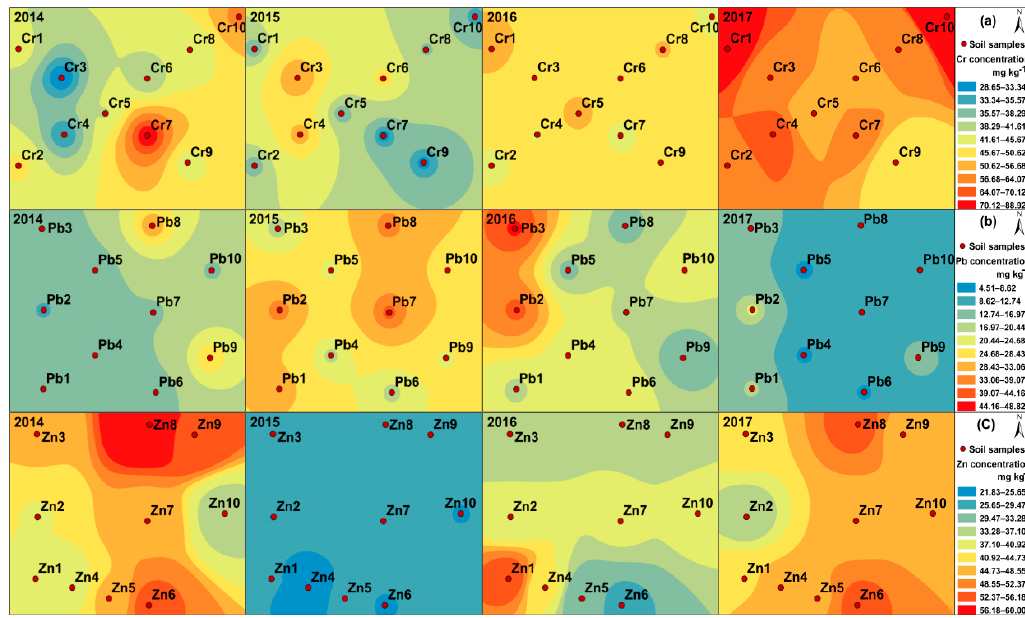
Figure 2. Spatial distributions of heavy metal concentrations in soil from 2014 to 2017: ( a ) Cr addition site; ( b ) Pb addition site; and ( c ) Zn addition site.